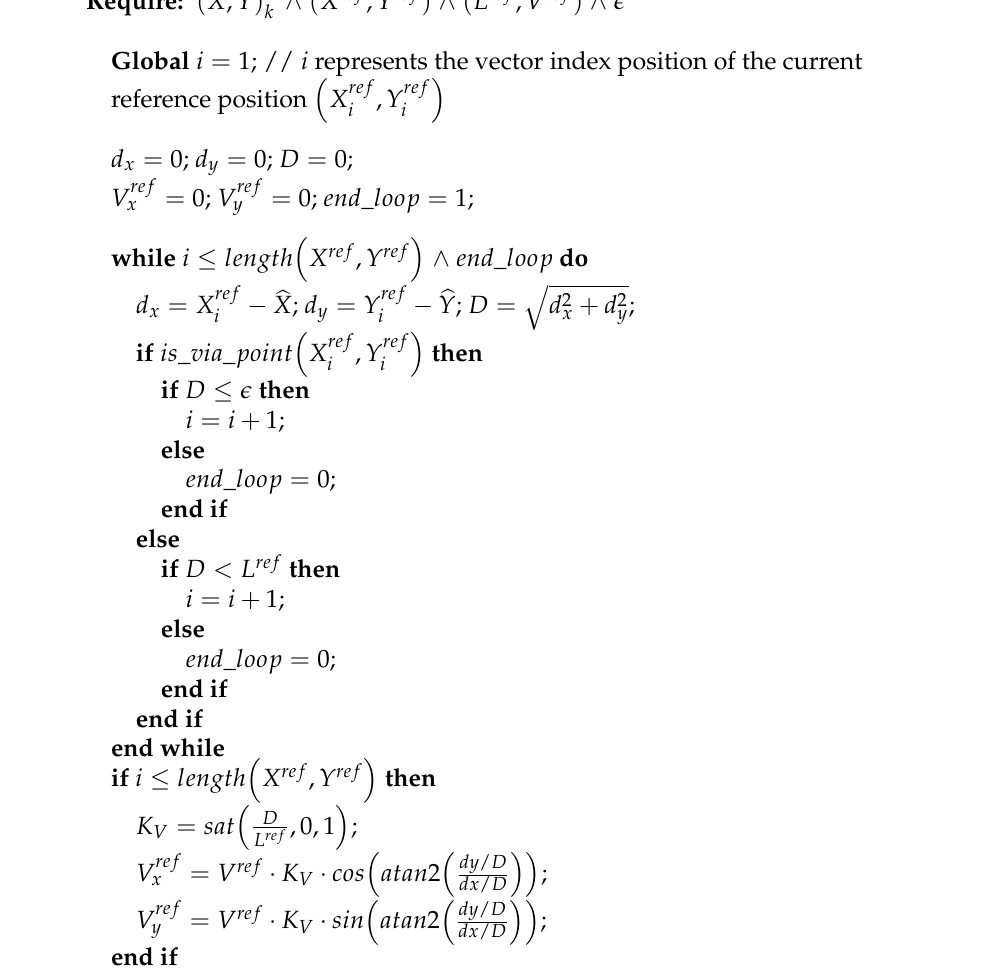
Algorithm 1: Calculate ( V ref x , V ref y ) T